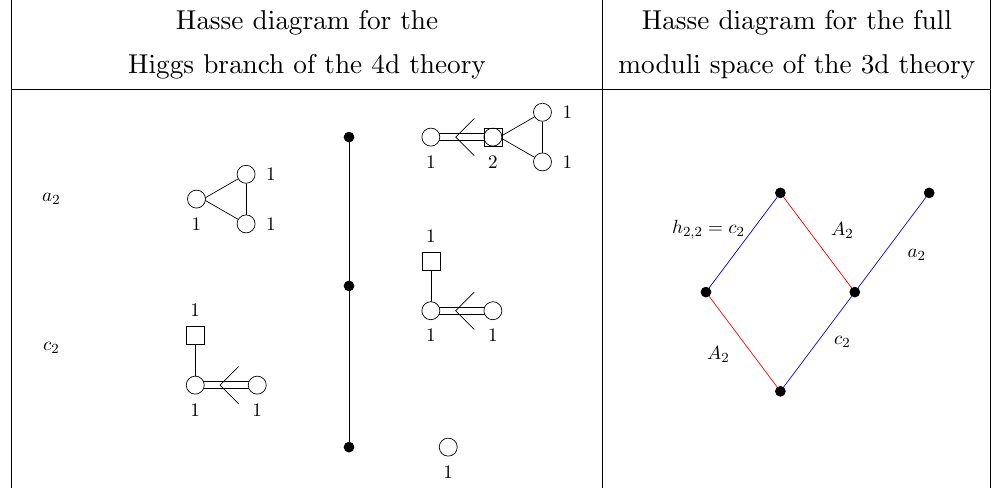
Table 6 . C 2 U 1 theory. Left : Hasse diagram for the Higgs branch of the 4 d (cid:2) To the right of the Hasse diagram are the magnetic quivers for the closures of the leaves and to the left are magnetic quivers for the slices. Right : Hasse diagram for the full moduli space of the theory in 3 d = N